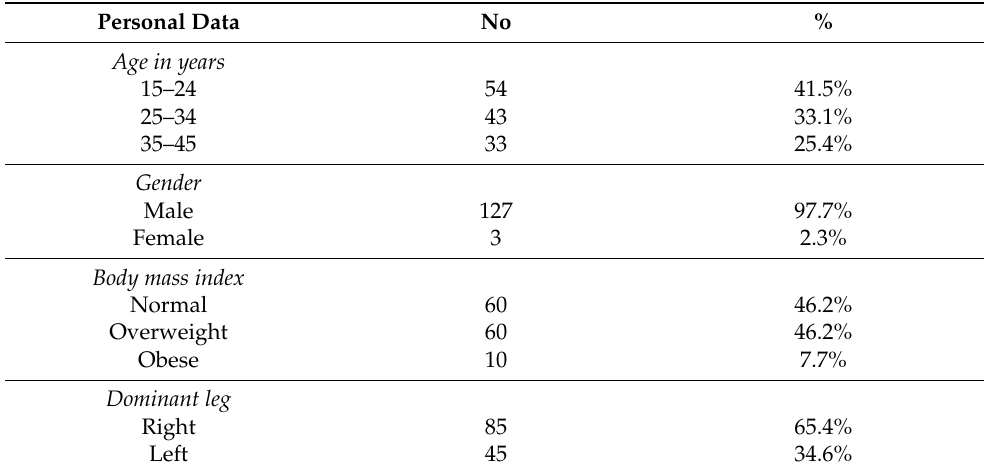
Table 1. Personal data of patients undergoing ACL reconstruction in Aseer Central Hospital, Saudi Arabia. Personal Data No